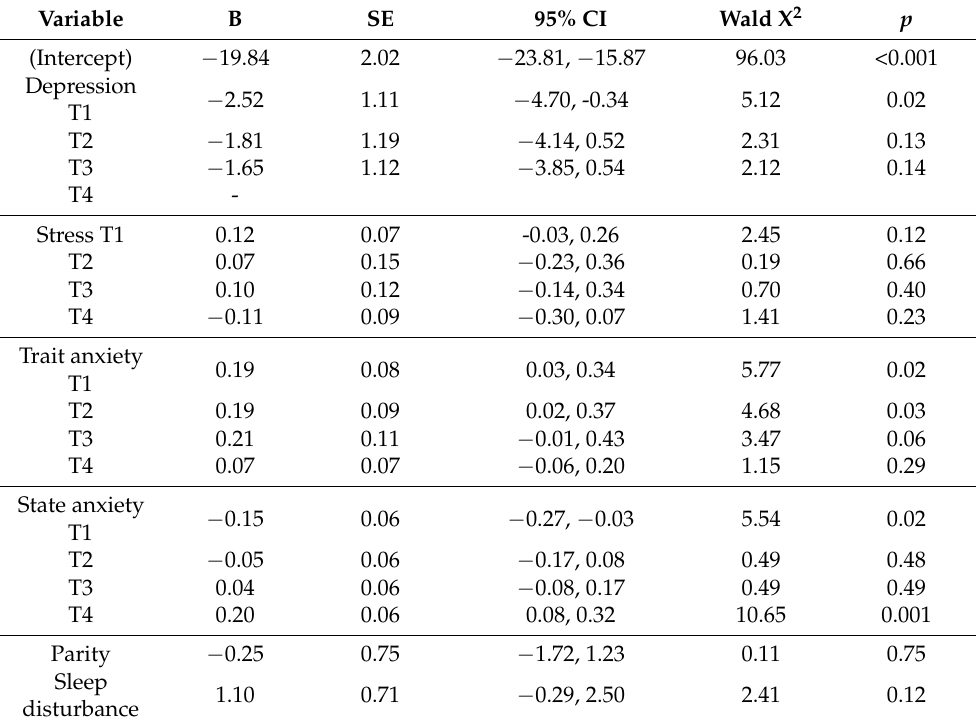
Table 6. Prediction of perinatal stress and anxiety on postpartum